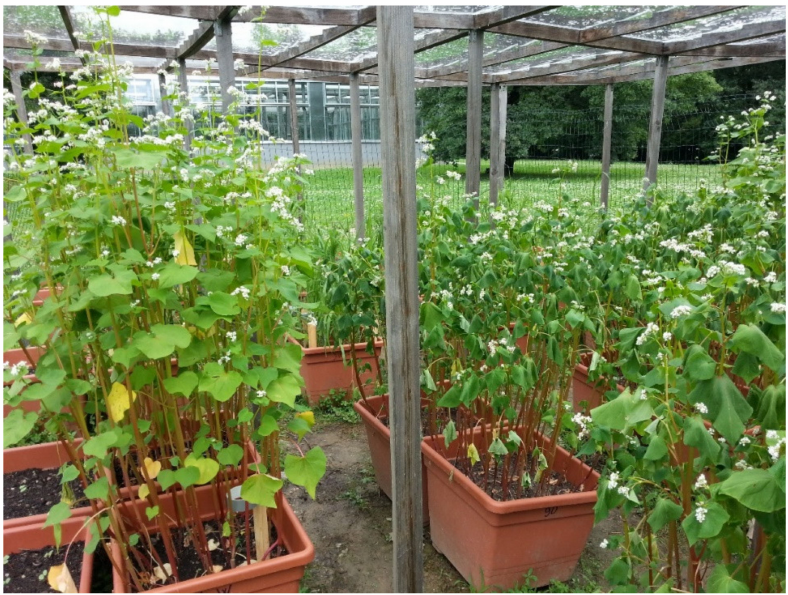
Figure 1. Experimental plants at 24 days from the start of the experiment. Left, control; right, water